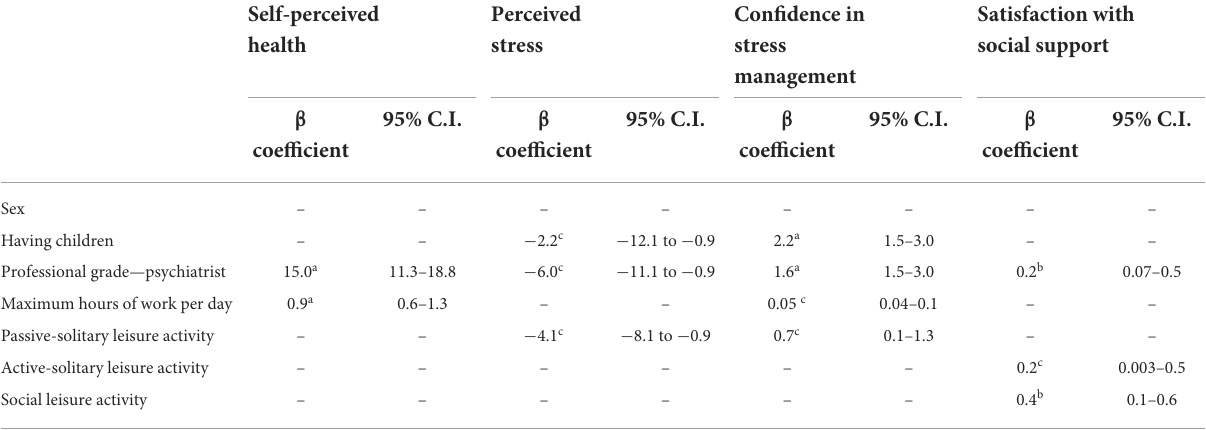
TABLE 2 Influence of leisure activities on self-perceived health, perceived stress, confidence in stress management and satisfaction with social support—final linear regression